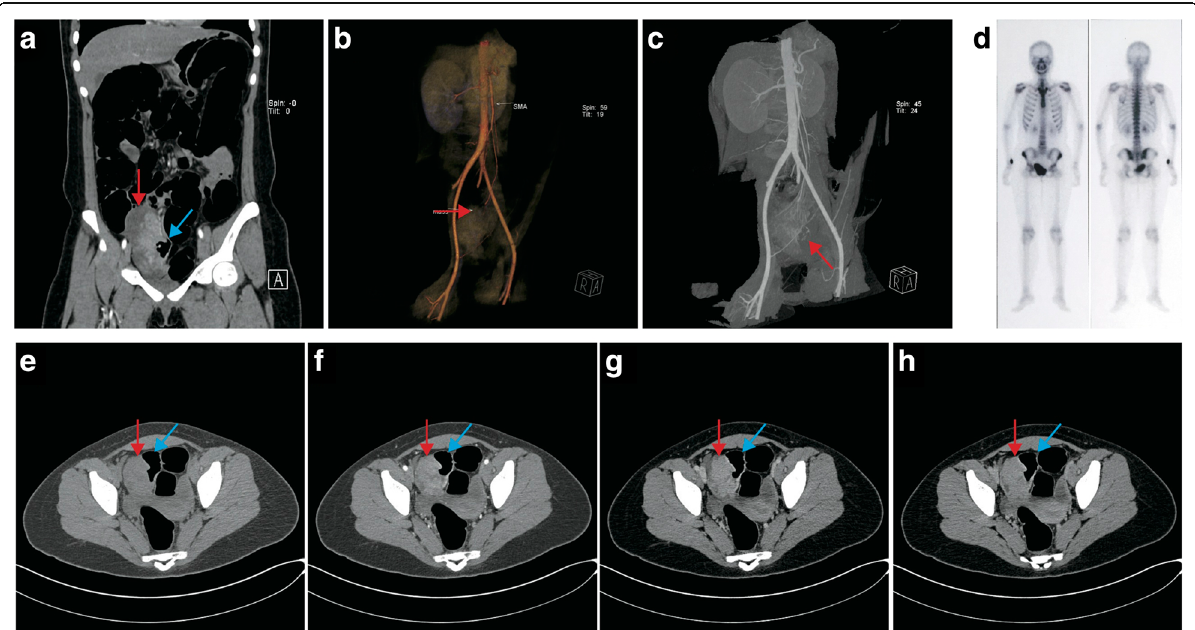
Fig. 1 Abdominal and pelvic CT scan, 3D reconstruction and ECT demonstrating the tumor originating in the ileum of the patient. CT scan was performed immediately after enteroscopy. Thus, the patient ’ s intestine was dilated. a Coronal scan arterial phase reveals that the tumor was derived from ileal wall. b 3D reconstruction with volume rendering technique illustrates the supporting vasculature. c 3D reconstruction with maximum intensity projection demonstrates major vascular support of the tumor. d Postoperative bone scintigraphy proved that there was no lesion in her skeletal system. e Plain scan revealed pelvic a 10.0 × 7.6 × 5.3 cm mass with areas of necrosis. Most of the mass was had clear boundaries with surrounding tissues, although part of it obliterated the lumen of the terminal ileum. Workup for metastasis was negative. f - h Contrast-enhanced arterial, venous, and delayed phase pelvic CT scan revealed enhancement of the solid part of the tumor in all phases, with the peak in the arterial